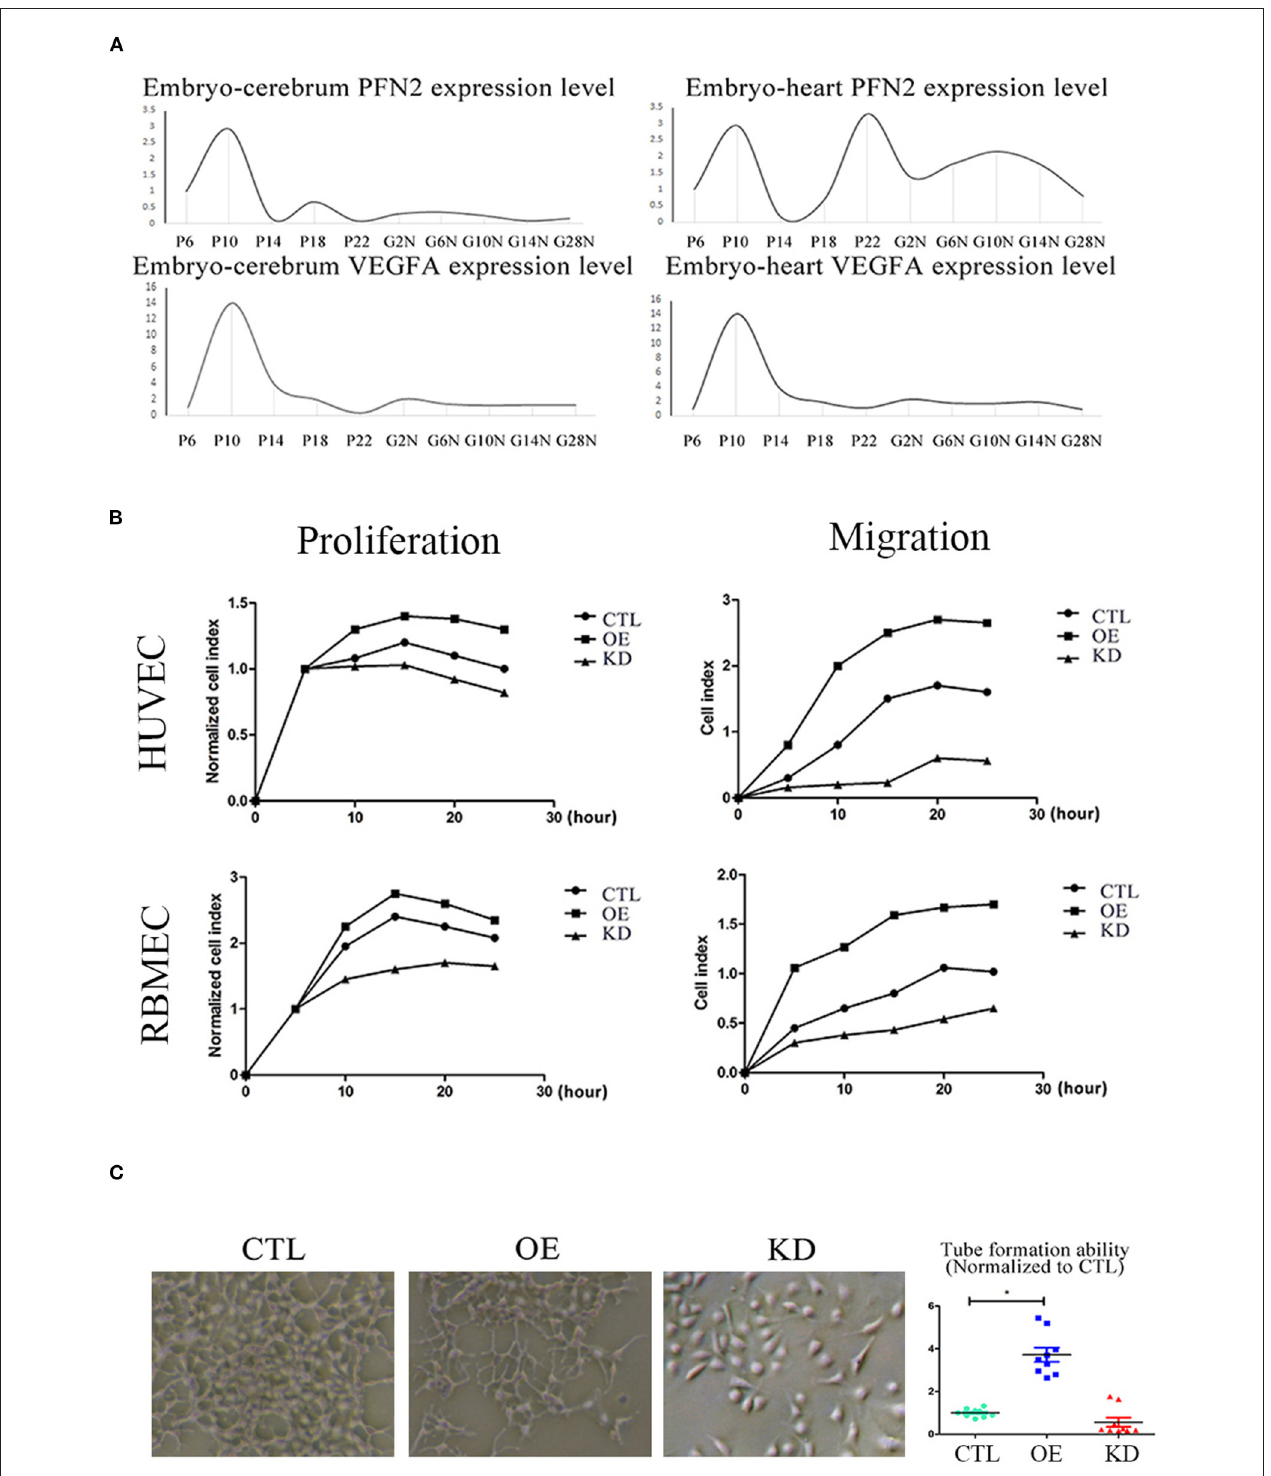
FIGURE 5 | PFN2 promotes proliferation and migration of ECs, as well as tube formation and reaches the maximum level in 10-day embryo. (A) The mRNA levels of PFN2 and VEGFA at different developmental stages of gerbils ( n = 15) embryo (prenatal), brain and heart (postnatal). (B) PFN2 significantly promoted proliferation of HUVECs ( n = 3) and RBMECs ( n = 3), as well as showed a positive effect on migration of HUVECs ( n = 3) and RBMECs ( n = 3). (C) The tube length in PFN2-overexpressing ECs (OE) was significantly increased than that in blank CTL and PFN2 knockdown ECs (KD), n = 3. * p < 0.05, one-way ANOVA and repeated-measures ANOVA